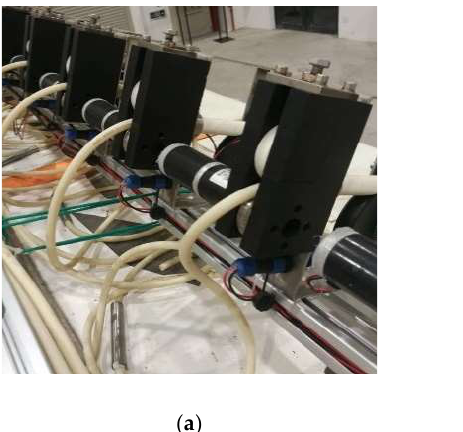
Figure 12. Sampling system ( a ) Architectural overview of the sampling system. ( b ) Composition of the sampling system.